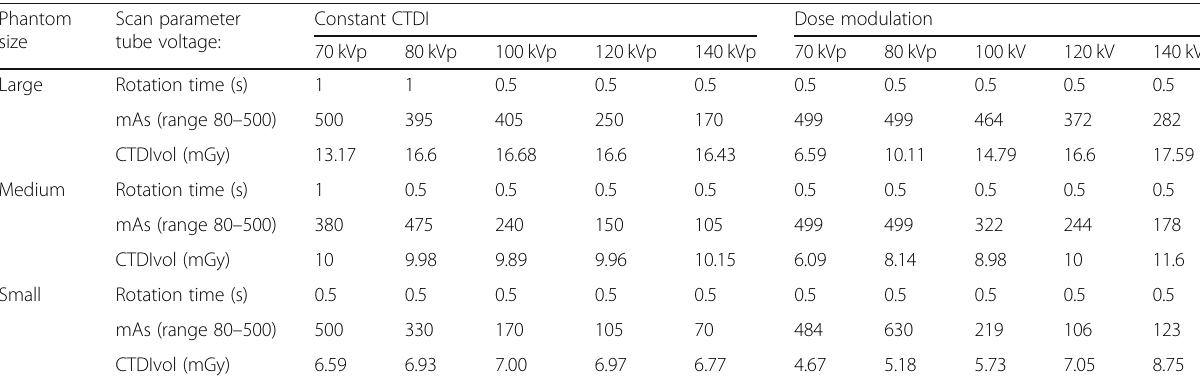
Table 1 Details of the contrast medium specifics Phantom